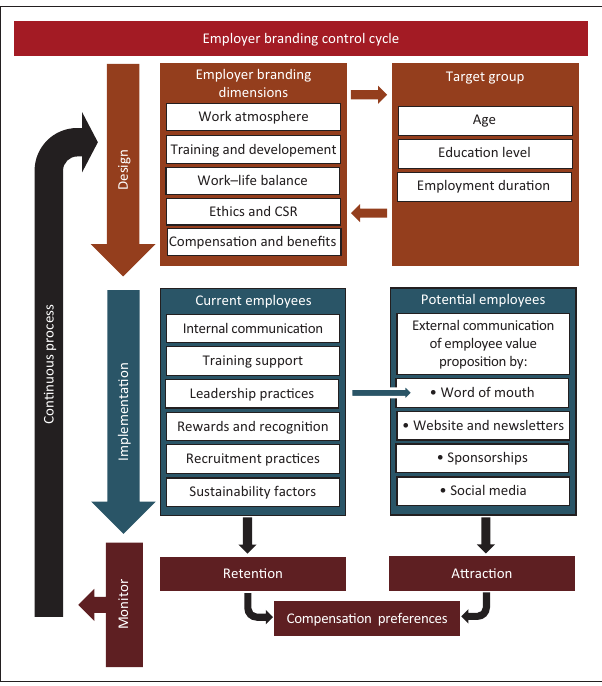
FIGURE 4: Employer branding control cycle